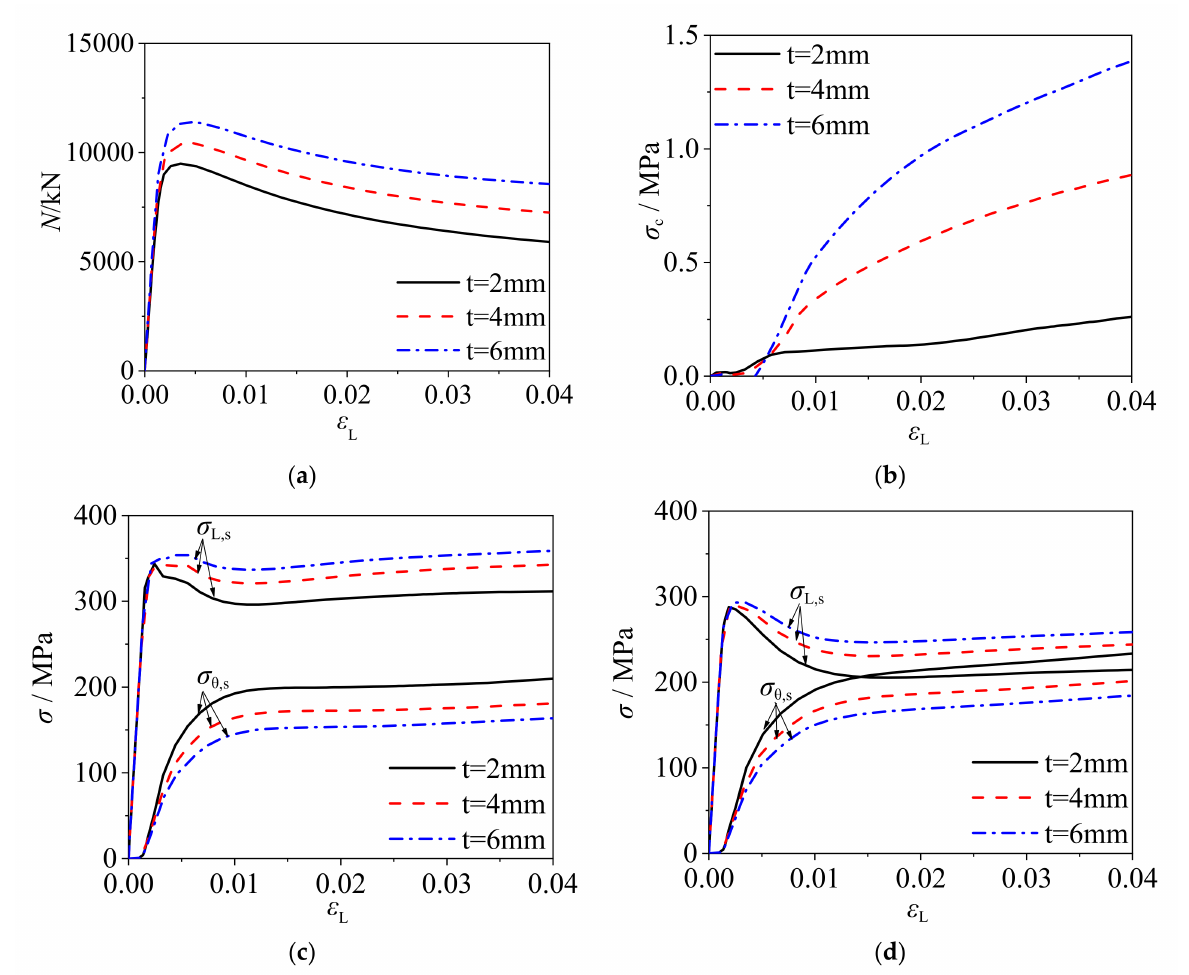
Figure 8. The influence of t on the mechanical performance of CFCFST stub columns: ( a ) load–strain curves, ( b ) radial stress–strain curves of core concrete, ( c ) stress–strain curves of steel tubes at endpoint, and ( d ) stress–strain curves of steel tubes at